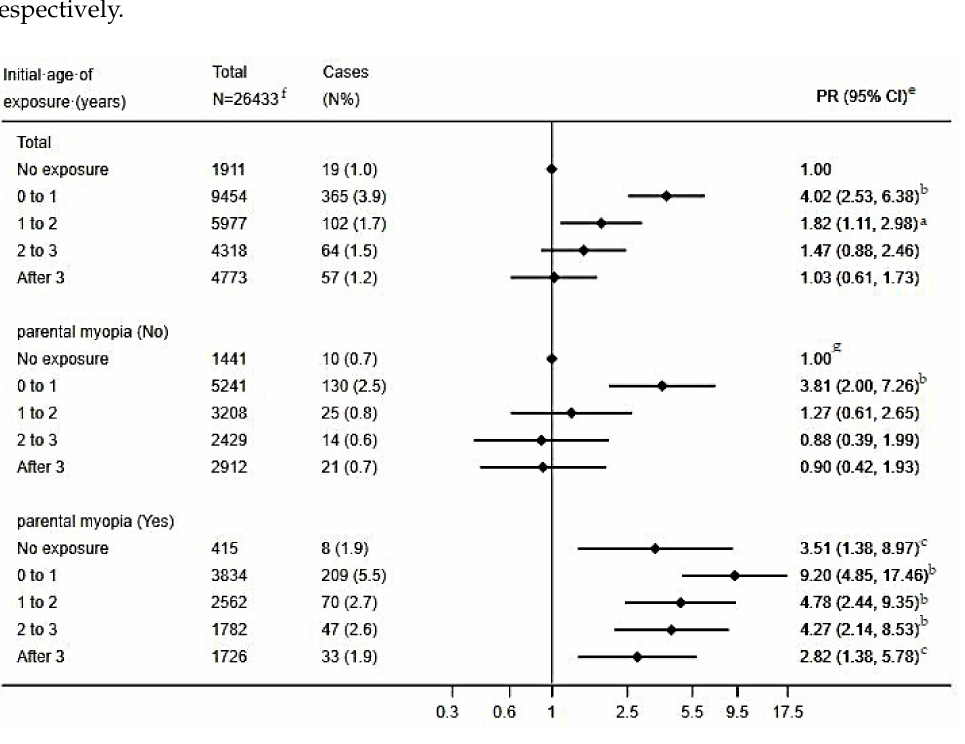
Figure 1. Association between the initial age of screen exposure and myopia amongst preschoolers. e : Adjusted for children’s age, gender, feeding patterns, and premature birth; parental age at